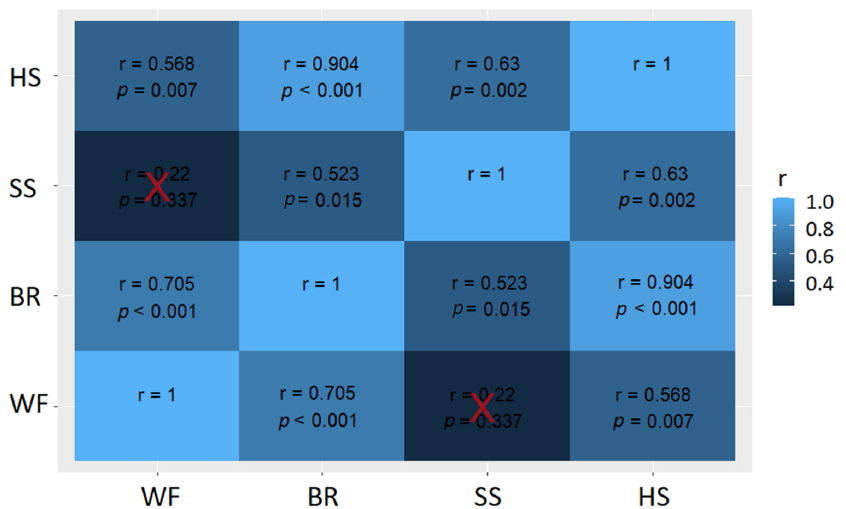
Figure 3. Heat map of correlations of the outcomes of the animal-based indicators regarding the state of consciousness during bleeding in waterbath stunned broilers (WF: presence of wing flapping; BR: presence of breathing; SS: presence of spontaneous swallowing; HS: presence of head shaking) observed when assessing 19 batches from six different slaughterhouses. The values in the table are Spearman’s rank correlation coefficients (r) and p- values. Red crosses indicate non-signifi- cant correlations ( p > 0.05).